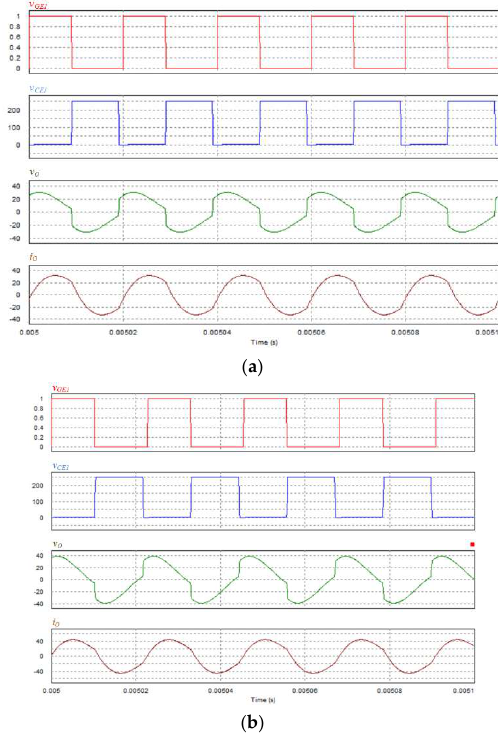
Figure 20. Simulation waveforms v GE1 (duty cycle), the voltage across the power switch voltage v CE1 , the output voltage v o , and the output current i o under the condition that the workpiece is 750 °C: ( a ) traditional control strategy, ( b ) proposed MPPT heating control strategy.